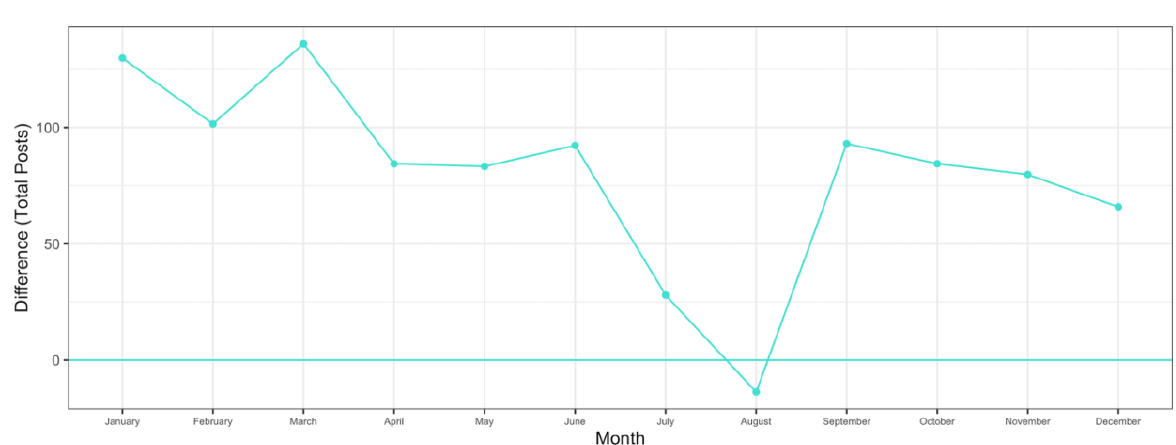
Figure B5. Difference in total posts by fact-checkers between 2020 and 2019. Each data point represents the difference between 2020 and 2019 in total posts by fact-checkers for each month. Total posts for a month are calculated by adding the total posts by all fact-checking organizations in a